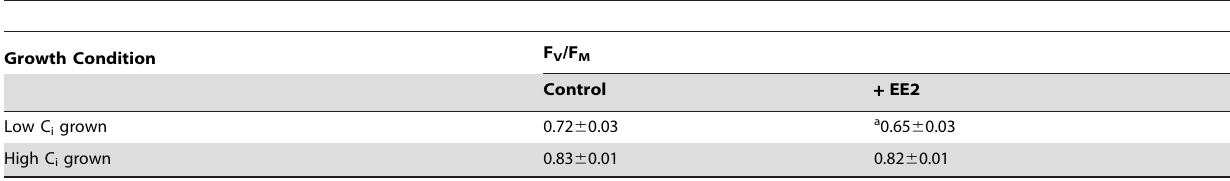
Table 2. Effects on F V /F M on cells of C. reinhardtii grown at high and low C i without (control) and with addition of EE2 in the culture media.